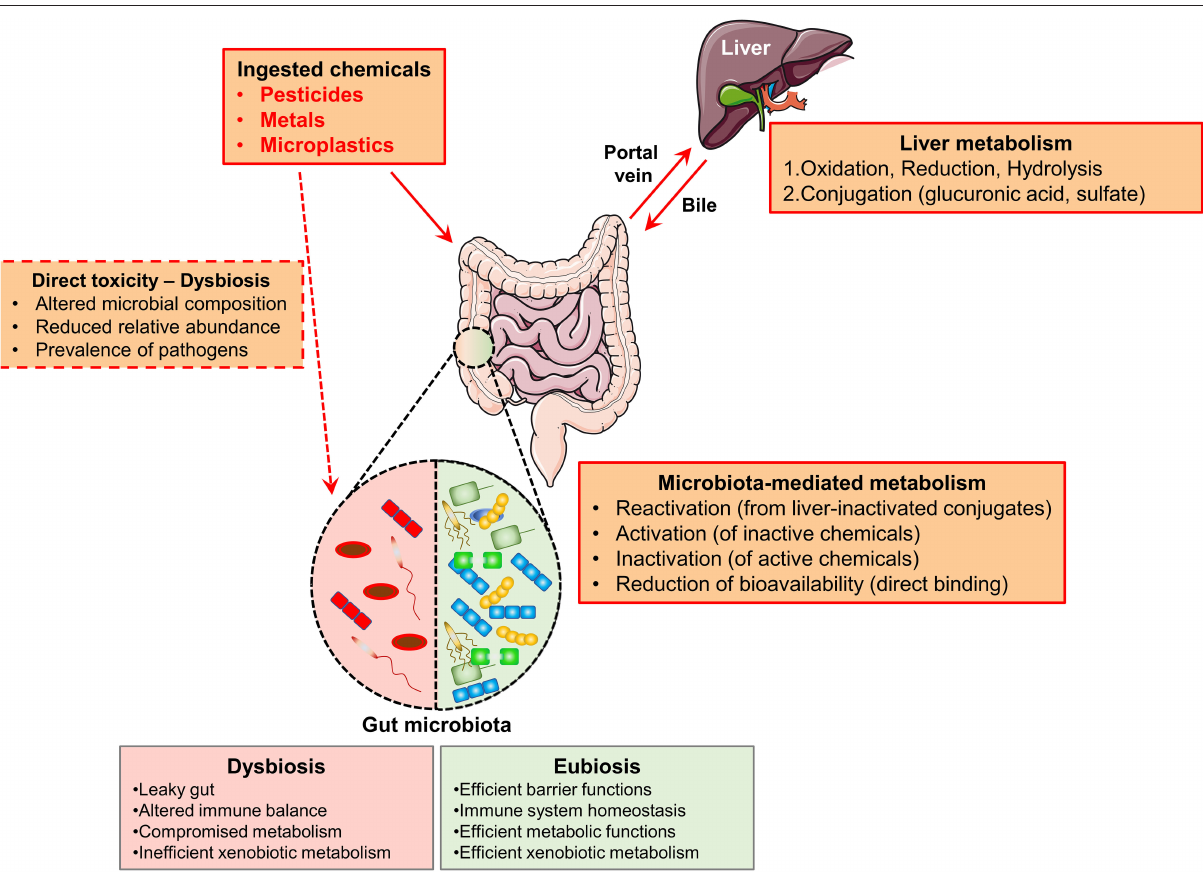
Frontiers in Medicine |